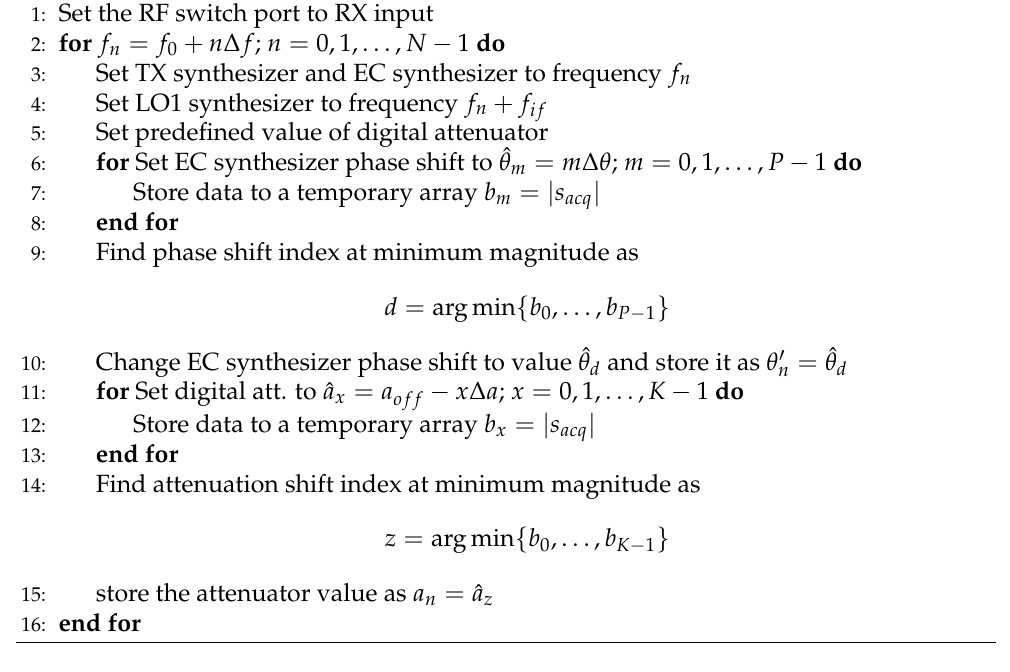
Algorithm 1 Echo Cancellation